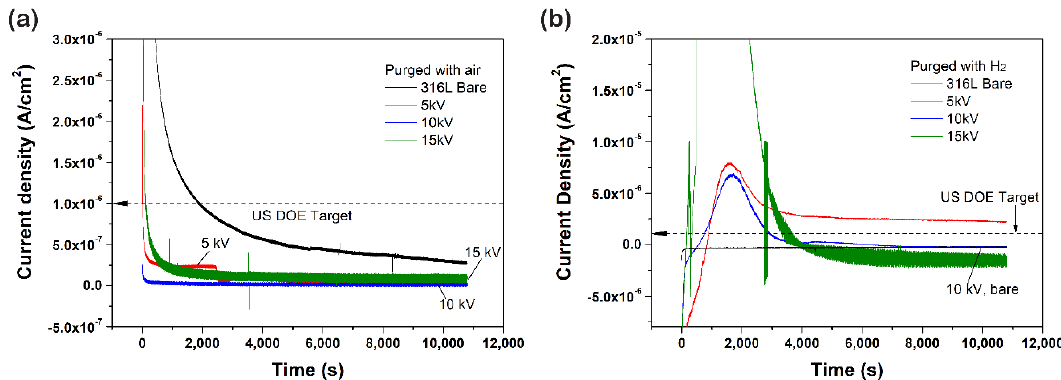
Figure 6. Potentiostatic polarization curves of N + -implanted samples in 0.5 M H 2 SO 4 at 70 °C ( a ) constant 0.6 V with purged air and ( b ) constant –0.1 V with purged H 2 .